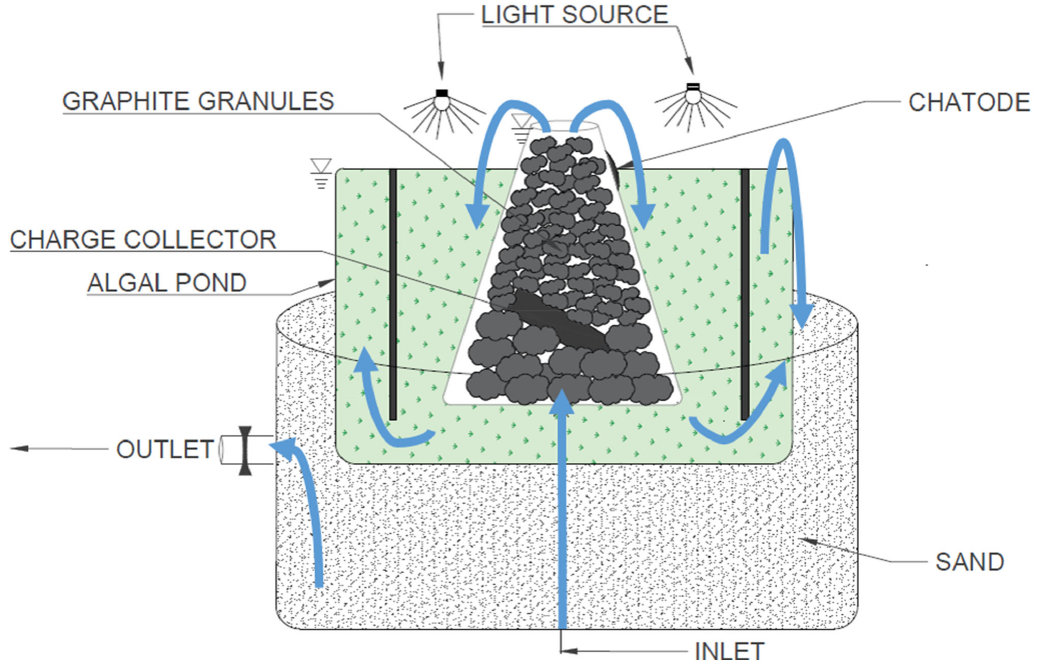
Figure 16. Representation of the algal ‐ assisted CW ‐ MFC integrated with a sand filter ( adapted from Gupta et al. (2015) [59]).